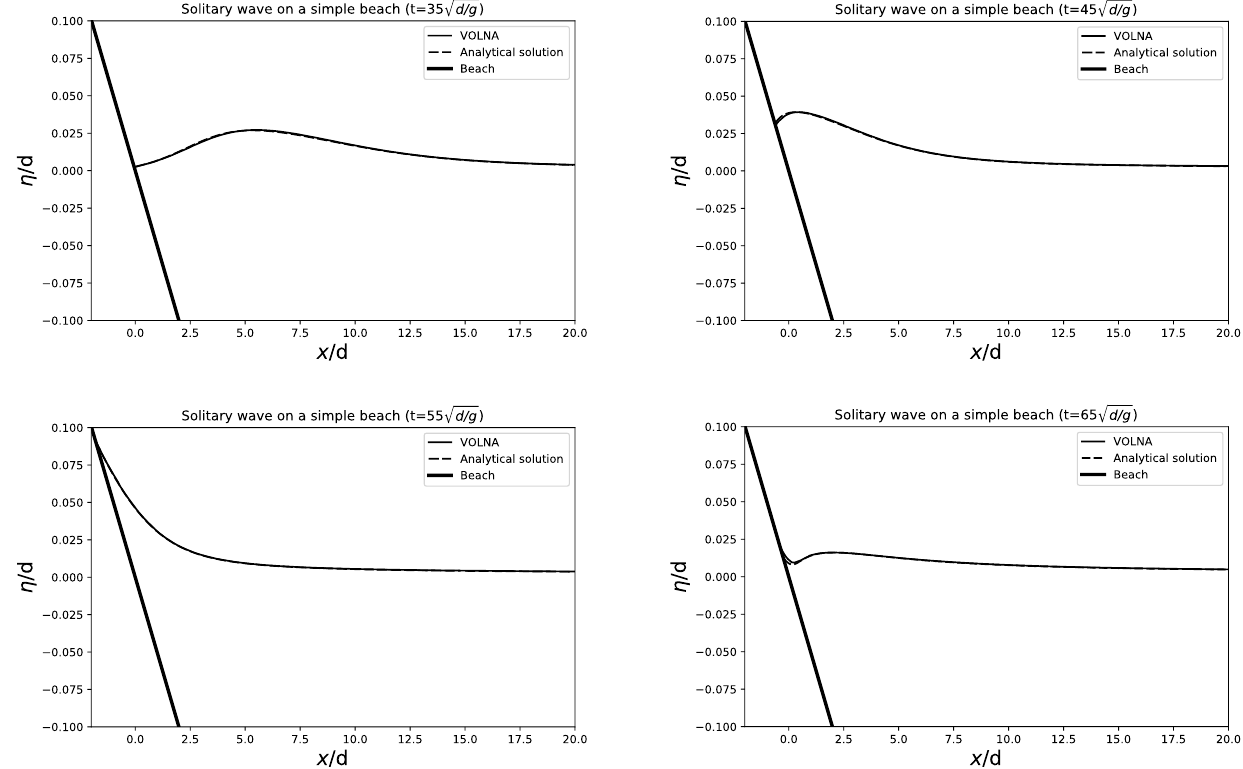
Figure 2. Solitary wave on a simple beach – comparison between the simulated run-up and analytical solution at the shoreline (time = 35, √ d/g ). Solid line – VOLNA; dashed line – analytical solution; thick line – beach. 45, 55, 65